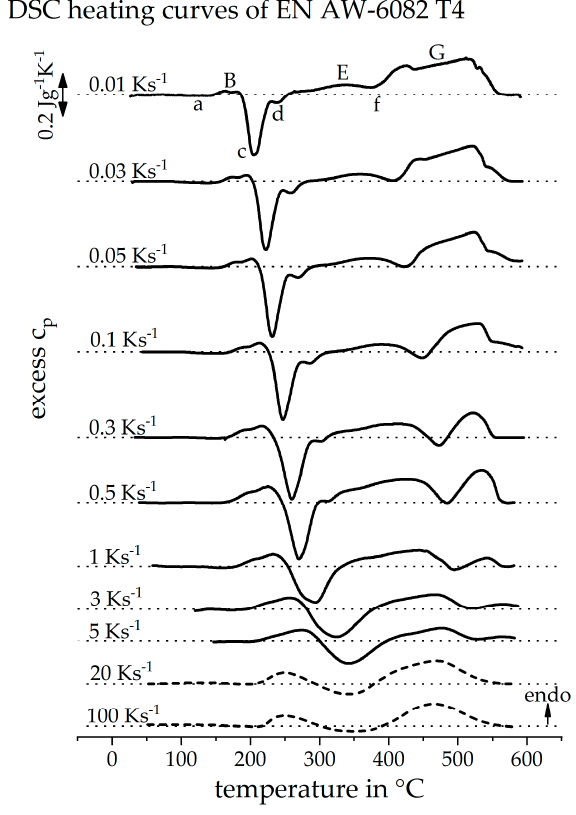
Figure 12. Heating curves of EN AW-6082 T4 with the conventional DSC and the reconstructed heating curves at 20 and 100 Ks − 1 .